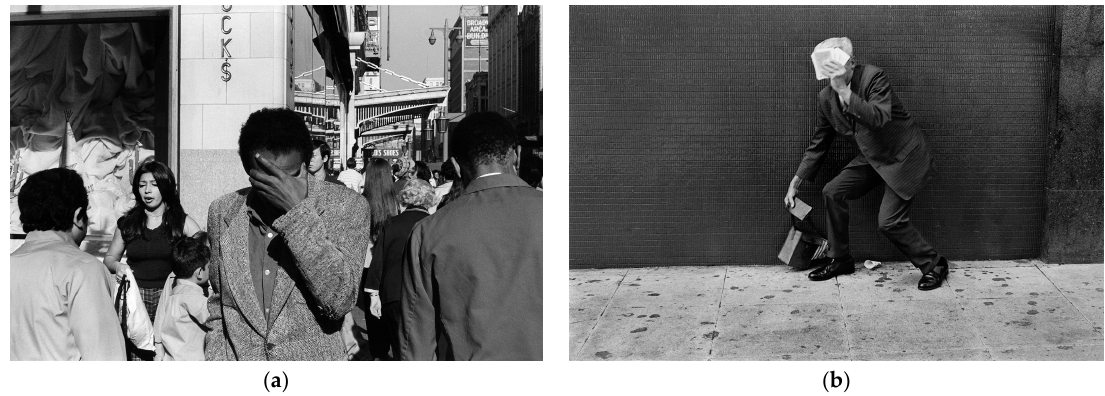
Figure 9. Anthony Hernandez, ( a ) Los Angeles #1 (1971); ( b ) Los Angeles #7 (1969), © Anthony Hernandez.